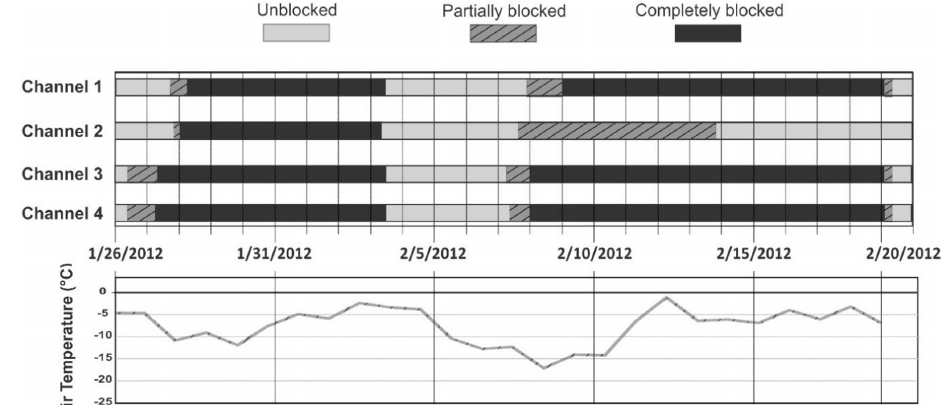
Figure 3. Mean daily air temperatures at a gauging station 7km downstream from the SWIPS and the timings of observed acoustic beam blockages during the 26 January–20 February 2012 time period. Temperature data extend up to and just beyond the upstream advance of the ice edge past the SWIPS site. Uncertainties in blockage transition timings were greatest ( ± 2h) at the starts and ends of partial blockages. Brief periods of partial blockage embedded in the completely blocked periods were not included in the